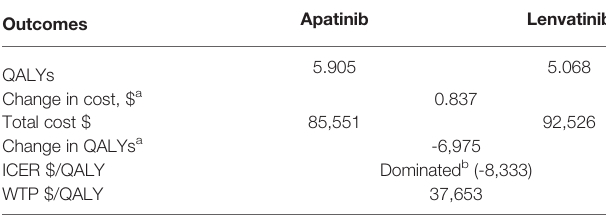
TABLE 2 | Baseline results.